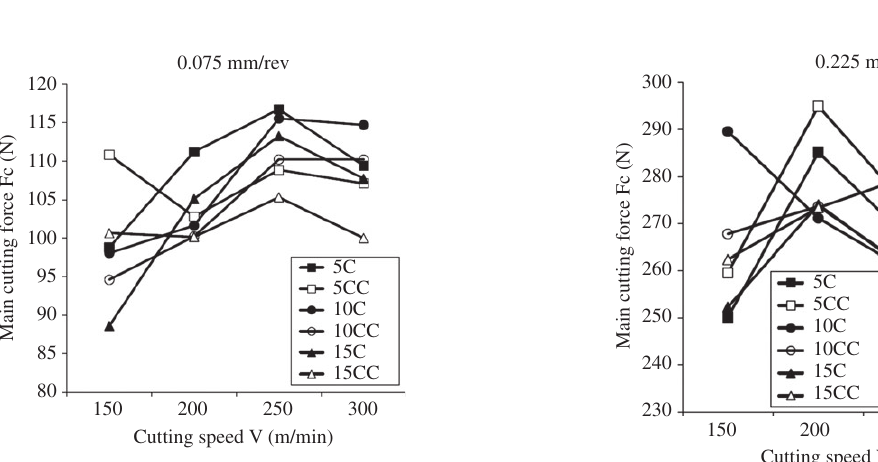
Figure 5 XRD result of composite. XRD analysis shows two main phases of Al and MgO. There are not any additional phases at the matrix- reinforcement interface (BRUKER D8 Advance X-ray diffraction, Germany).